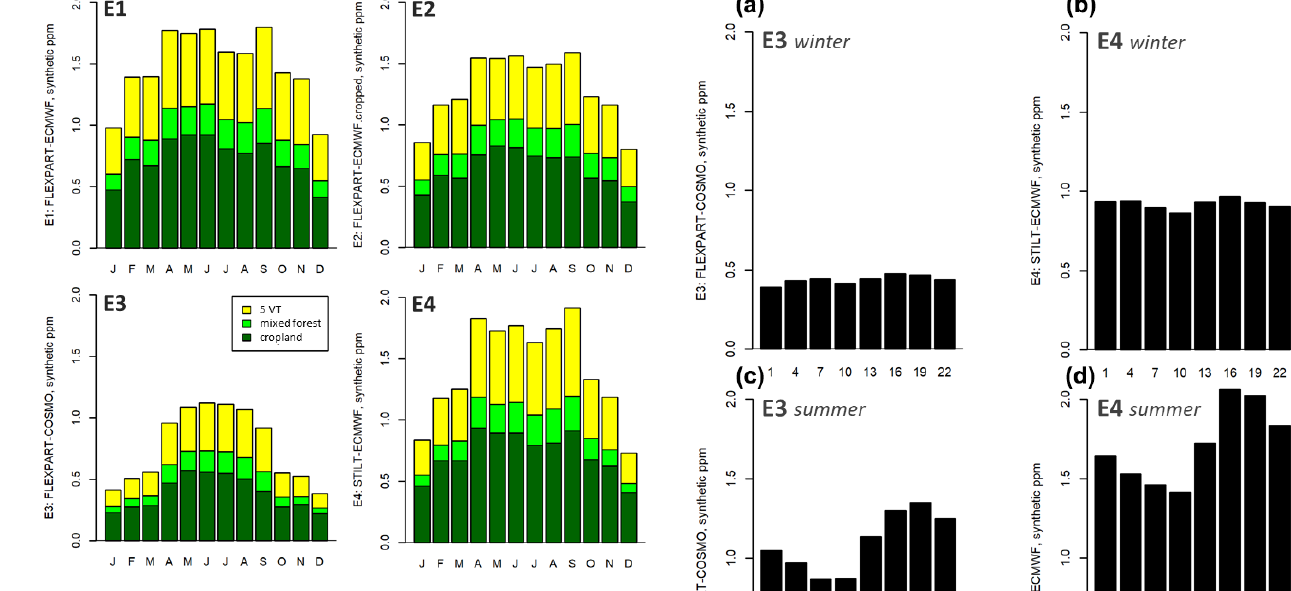
Figure A1. Mean monthly PBL sensitivity (JFJ, 2009–2017) to- wards (i) domain size (E1 vs. E2), (ii) meteorological input fields and spatial resolution (E2 vs. E3), (iii) LPDM implementation (E1 vs. E4), and (iv) combinations (E3 vs. E4).